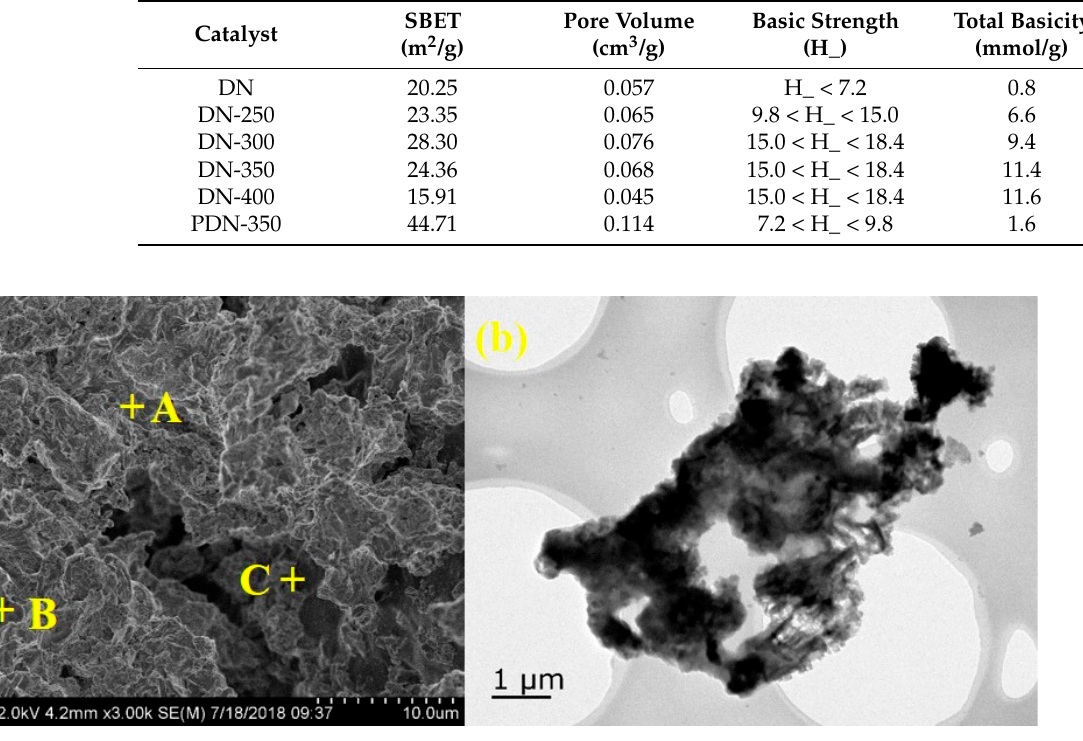
Table 1. Surface area results and basicity properties of catalysts.